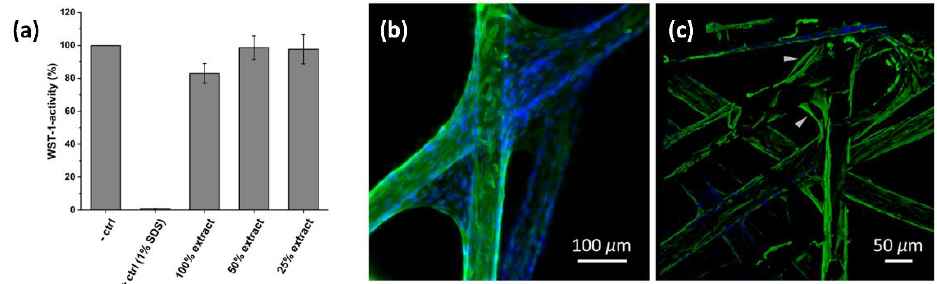
Figure 5. WST-1 activity of L929 cells after incubation with extracts of cell culture media in contact to 2 for 24 h ( a ); hdf seeded on 2 and stained for immunofluorescence imaging (blue: cell nuclei; green: type III intermediate filament vimentin of cytoskeleton, imaged by fluorescence microscopy) after a cultivation for 3 days ( b ). Thereby, hdf covered the complete fiber surface. To record a higher image volume, confocal microscopy was applied to reduce scattered light ( c ). At the angles of crossing fibers, hdf migrated from fiber to fiber (arrows) to grow all over the scaffold structure.